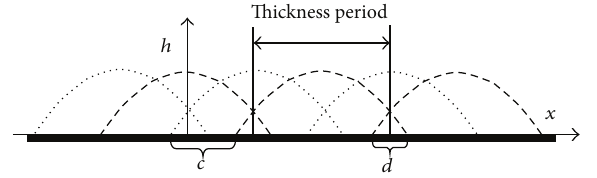
Figure 12: Coating thickness distribution when 𝑐 > 𝑑 and 𝑐 + 𝑑 ≤ 0.5 .